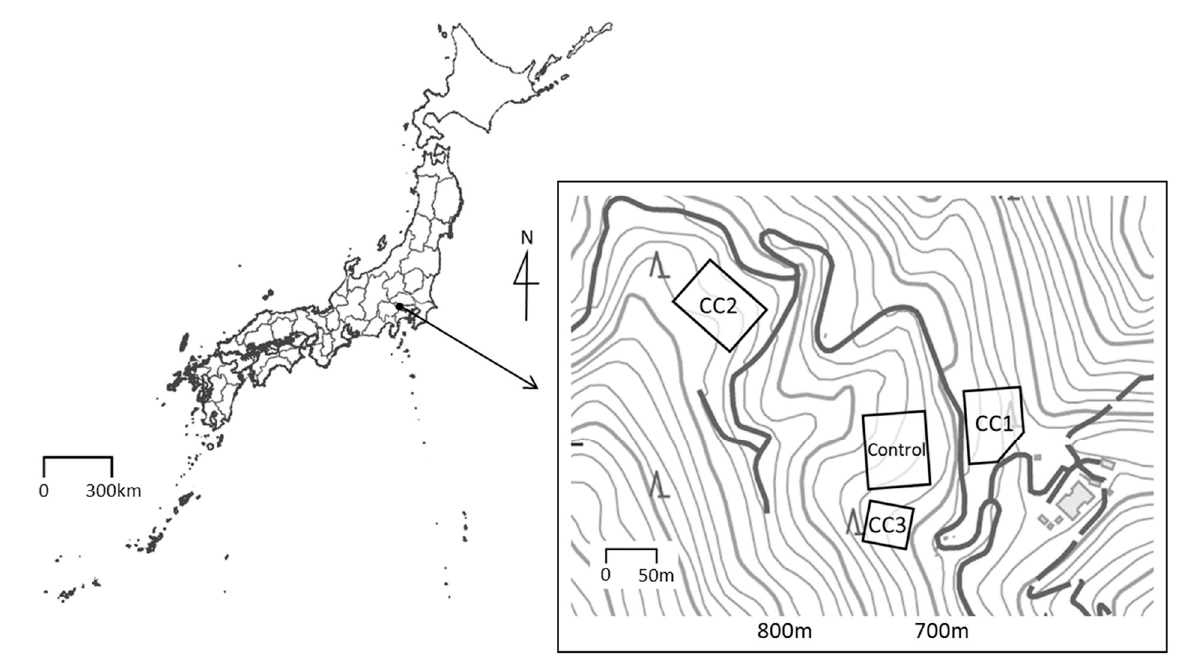
Figure 1. Location of the study site and measurement plots. This map was processed and created based on the Digital Topographic Map published by Geospatial Information Authority of Japan [15].